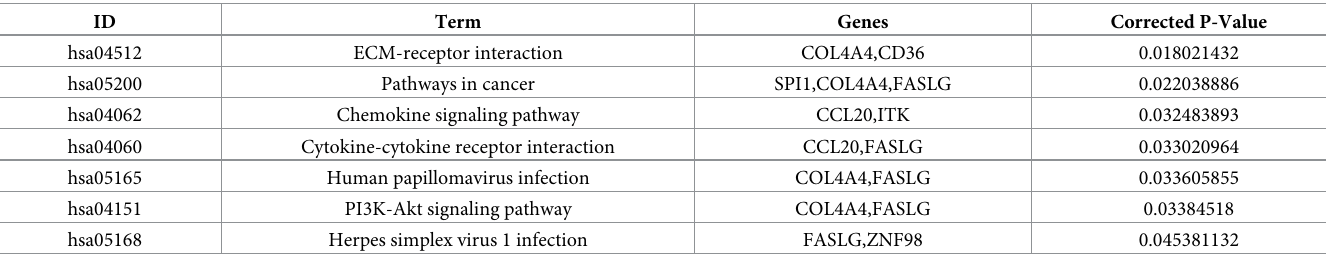
Table 8. KEGG pathway of DEmRNA in kidney renal clear cell carcinoma.